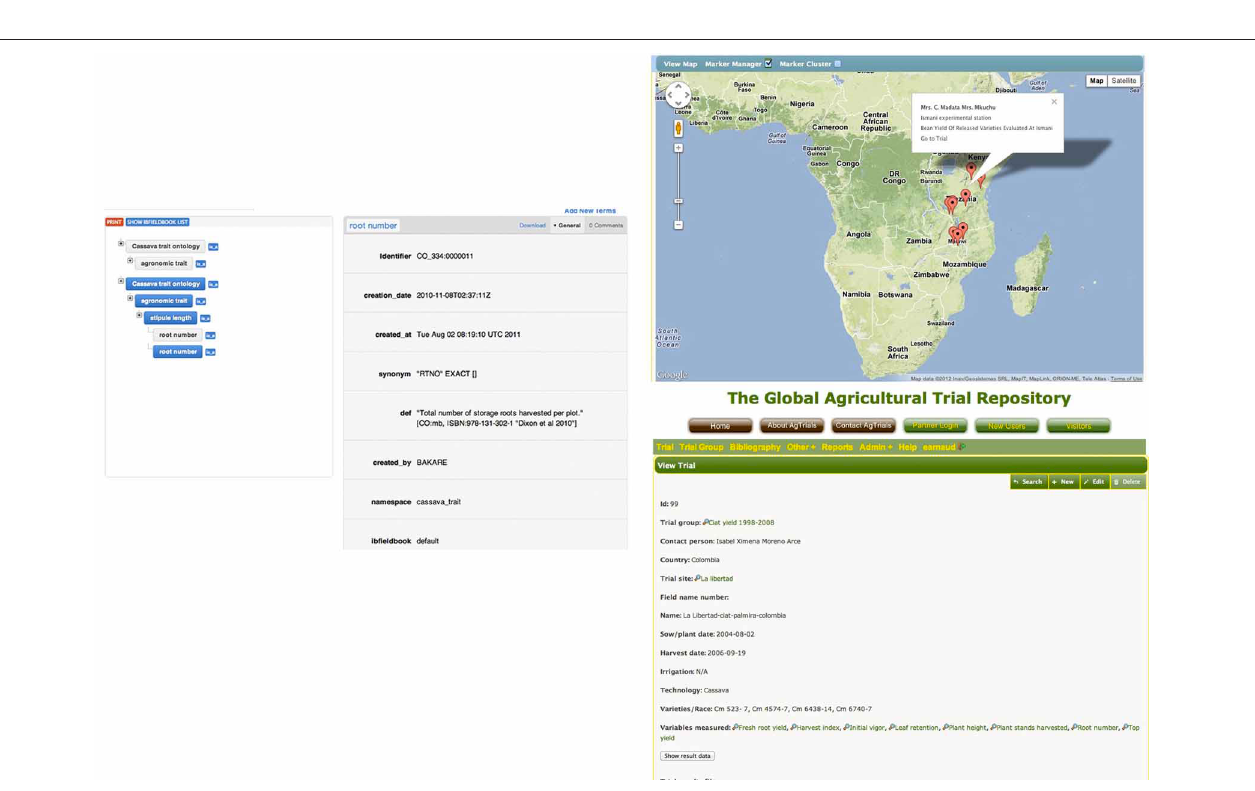
FIGURE 10 | Mockup of an ontological trait based access to the map of trials on Agtrials.